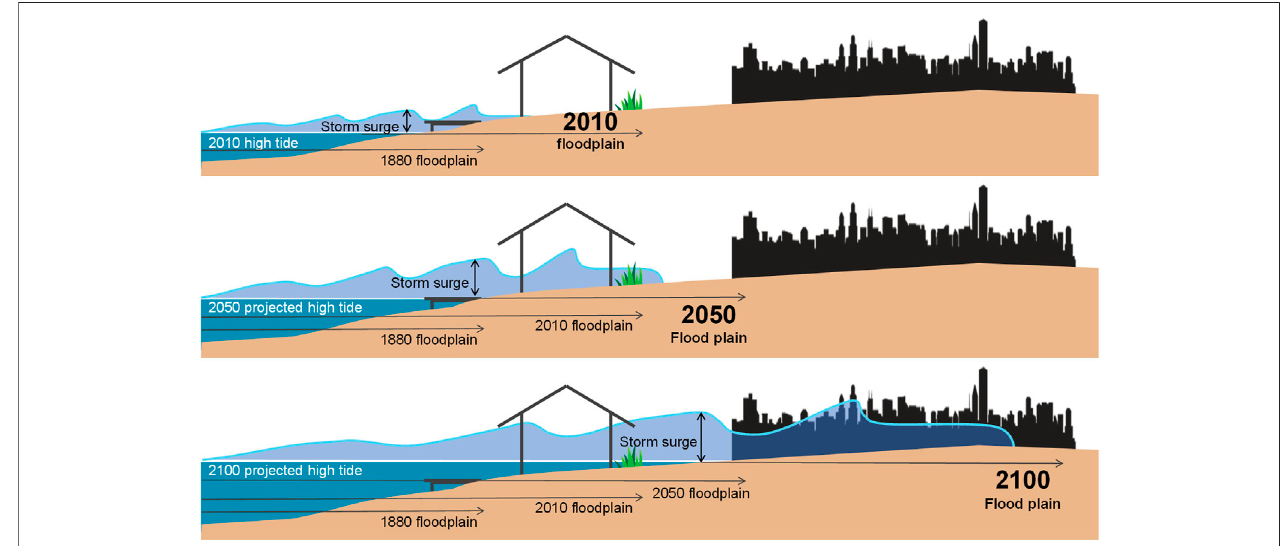
FIGURE 4 | Schematic illustrating the risk of coastal fl ooding under the present and future climates (Andersen and Shepherd, 2013; Kriebel and Geiman, 2014; Moftakhari et al., 2017a; Schindelegger et al., 2018).